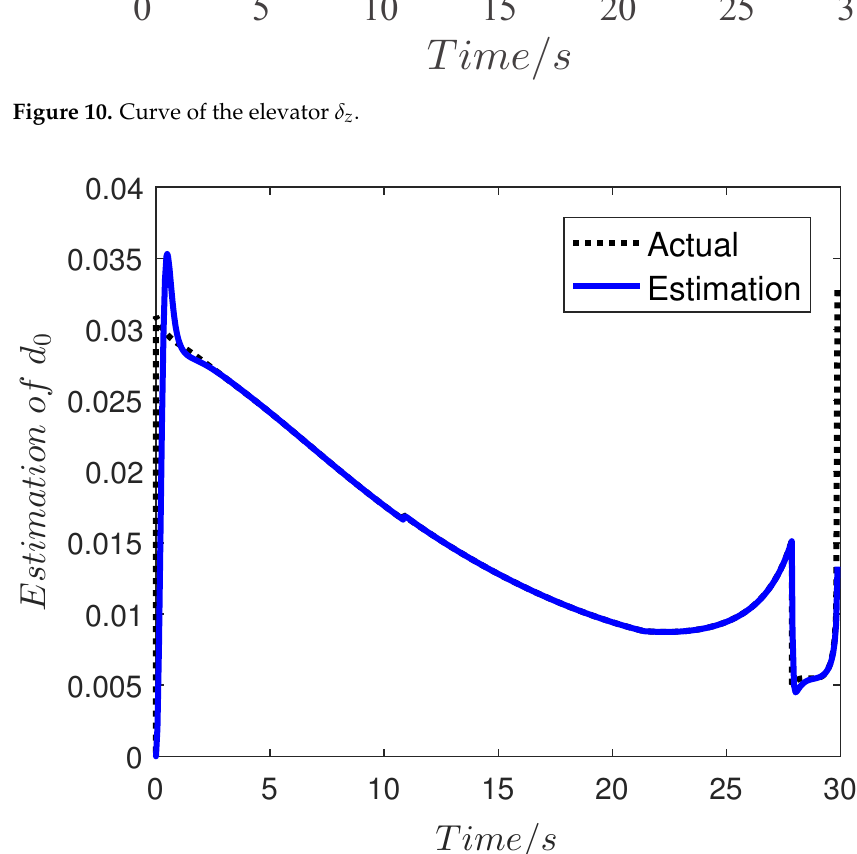
Figure 11. Curve of the estimation d 0